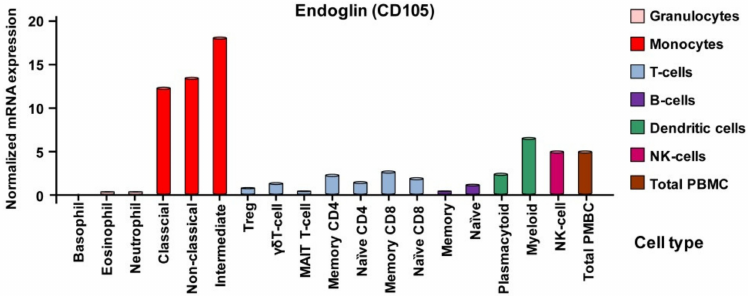
Figure 4. Transcript analysis of endoglin expression in peripheral blood cells. Transcript analysis of peripheral blood cells verified the very low presence of endoglin in granulocytes, low expression in T- and B-cells and showed a high expression in monocytes. In addition, dendritic cells express considerable amounts of Eng mRNA. Expression data were taken from the entry for Endoglin in the Human Protein Atlas